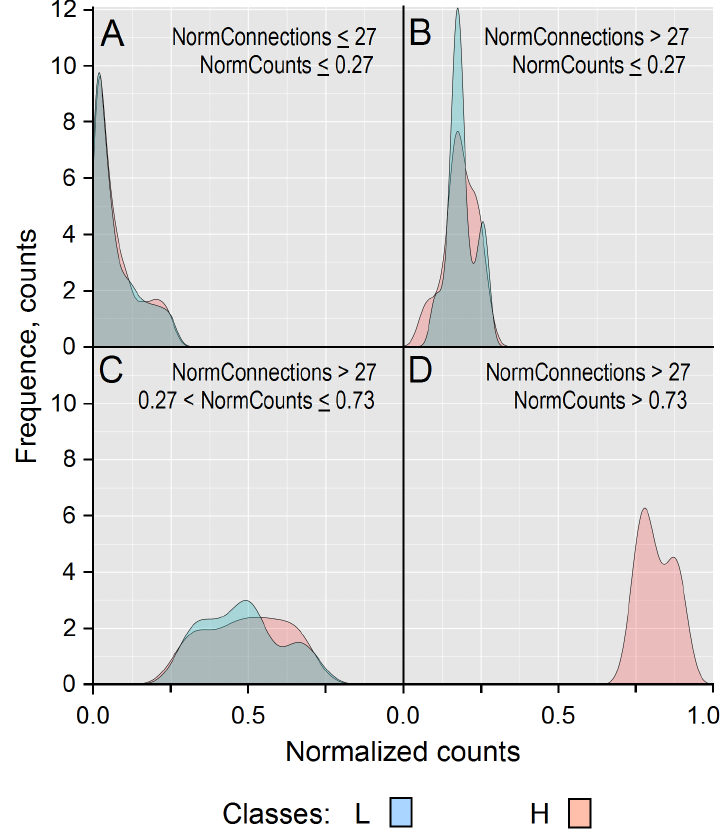
Figure 3. Frequencies (counts) of normalized gene counts (NormCounts) associated with genes of tumors from H and L cancer classes. From the 783 genes in this study, 609 were expressed in the H class and 559 in the L one. Panel ( A ) displays genes whose proteins had less than or equal to 27 normalized connections (NormConnections), and ( B – D ) those with more than 27 normalized connections. Considering proteins having less than 27 normalized connections (L = 509 and H = 531), frequency distributions were similar in L (blue) and H (red) classes for genes upregulated in less than 27% of tumor samples ( A ). Proteins having more than 27 normalized connections (L = 14 and H = 12) (BCD) are still present in a large proportion of the L class, even if they tended to be upregulated